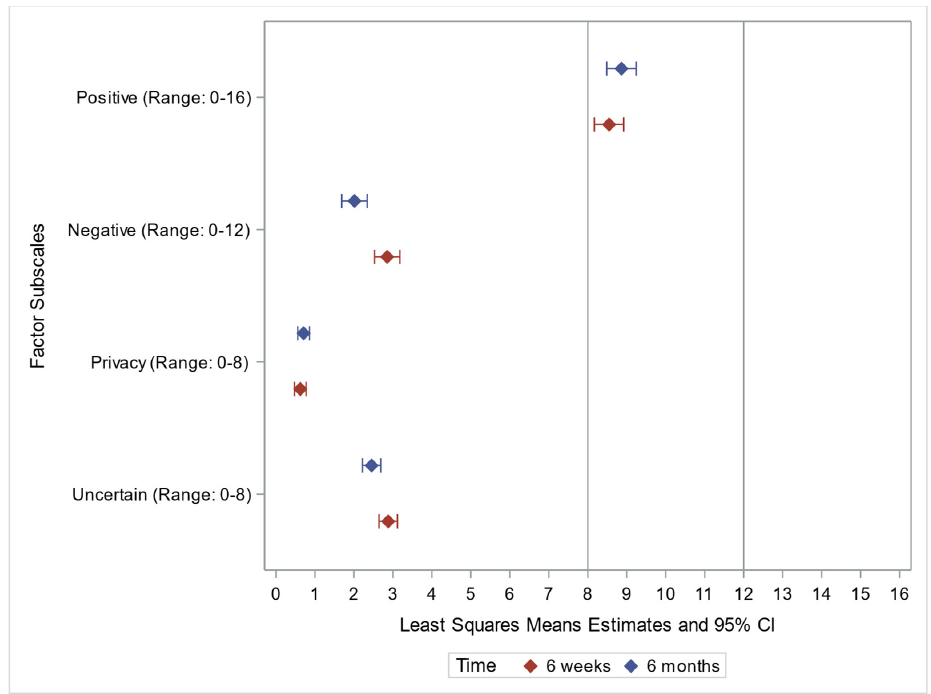
Figure 1. FACToR Scale Forest Plot.